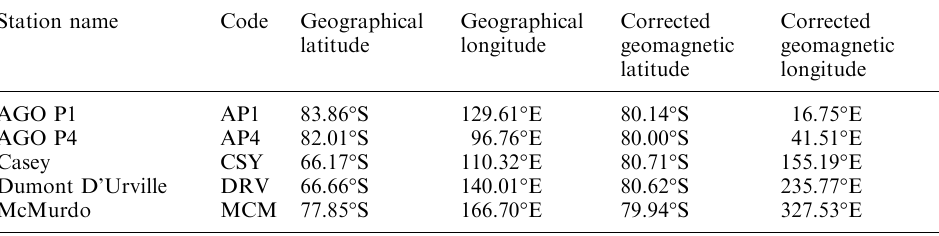
Table 1. Coordinates of sta- tions used to calculate